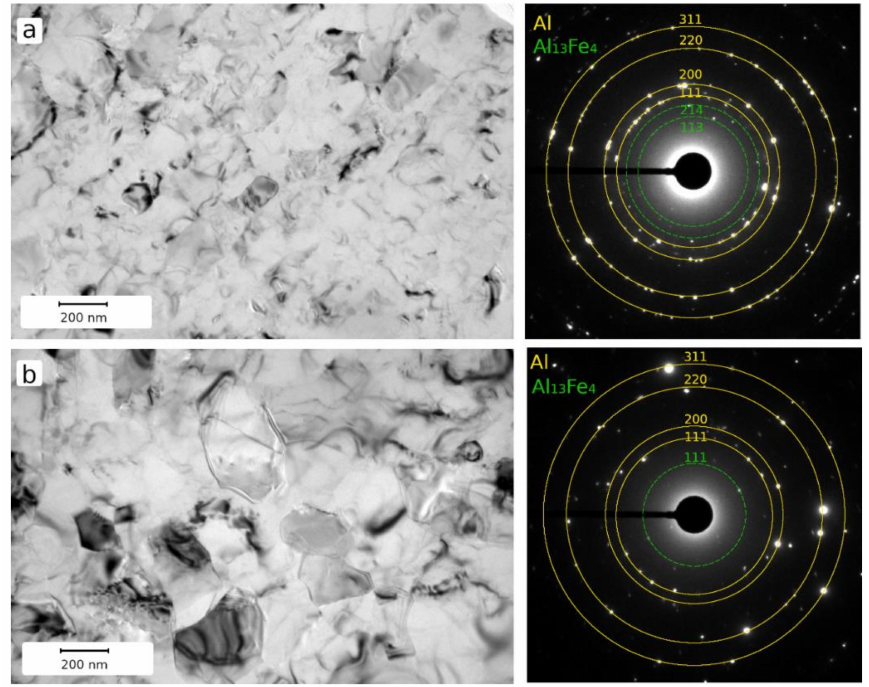
Figure 3. TEM bright-field ( left ) and SAED patterns ( right ) from the samples of the Al-2Fe ( a ) and Al-4Fe ( b ) after HPT. Indexed reflections are highlighted for the Al and Al13Fe4 phases with the corresponding